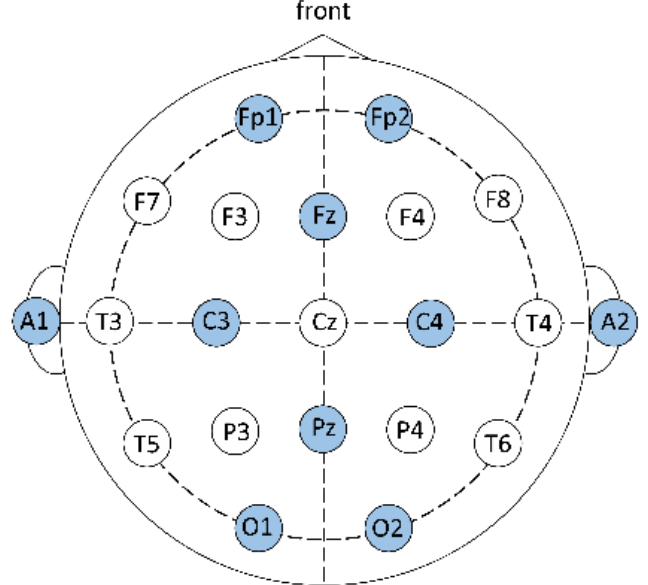
Figure 2. International 10–20 system, with the designator Fp corresponding to the frontal polar area of the brain, F to the frontal area, C to the central area, P to the parietal area, O to the occipital, T to the temporal area, and A to the auricular area. In this study, a total of 10 electrode positions on the head are recorded; they are Fp1 (left frontal lobe electrode), Fp2 (right frontal lobe electrode), Fz (frontal midline), C3 (left central), C4 (right central), Pz (middle line of vertex), O1 (left occipital lobe), O2 (right occipital lobe), A1 (left auricular), and A2 (right auricular), of which A1 and A2 are the reference electrodes.